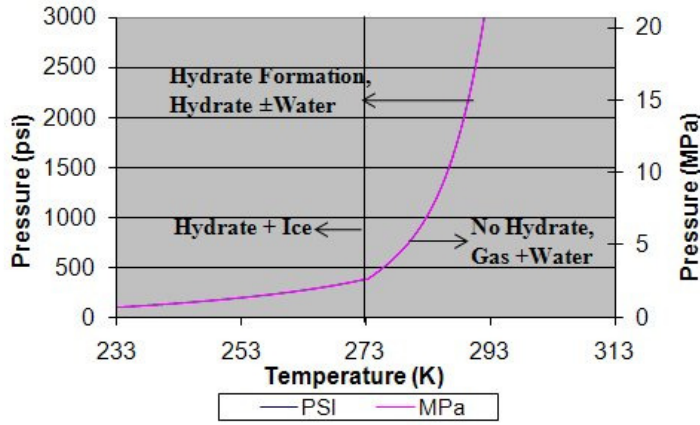
Figure 1. Typical Pressure-Temperature (P-T) methane hydrate formation diagram or methane hydrate stability curve